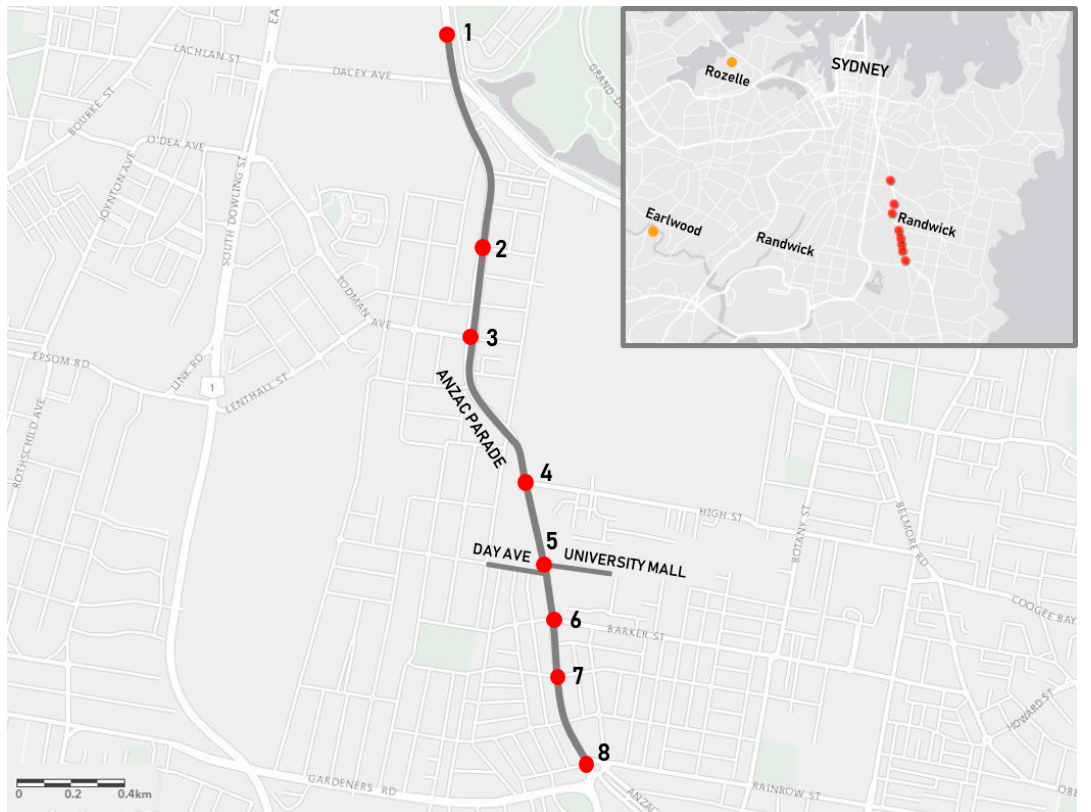
Figure 1. Route map outlining main road (Anzac Parade) and side streets (Day Ave and University Mall). Traffic counting locations defined in red circles, intersection names corresponding to numbered locations are outlined in Appendix A. Earlwood and Rozelle Air Quality Monitoring Stations identified by yellow dots.